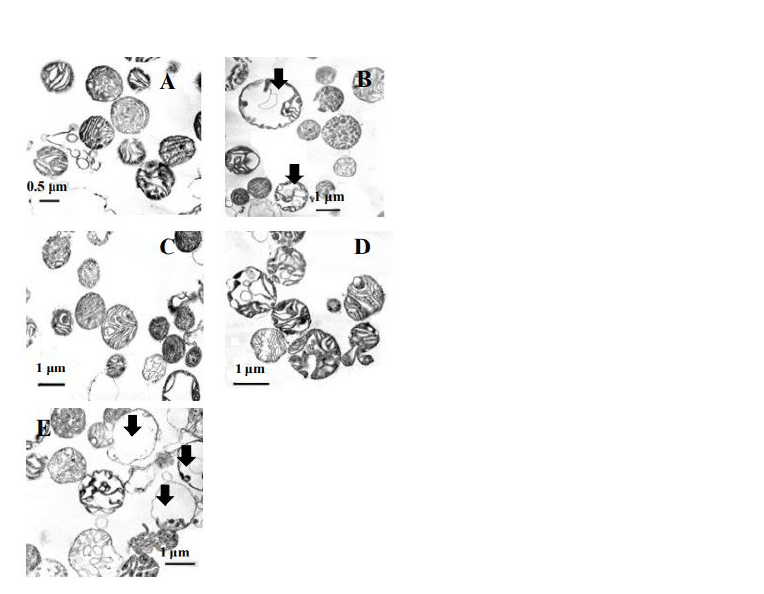
Figure 7. Micro-images of transmission electron microscopy of the E. magnusii mitochondria. ( A ) —control, ( B )—after a 3-min incubation with the antioxidant enzyme inhibitors of 4 mM ATZ and 4 mM DDC; ( C )—after a 1-min incubation with 5 mM Mg 2+ and 5 mM Pi followed by a 3-min treatment with the antioxidant enzyme inhibitors of 4 mM ATZ and 4 mM DDC; ( D )—after a 1-min incubation with10 mM NADH followed by a 3-min treatment with the antioxidant enzyme inhibitors of 4 mM ATZ and 4 mM DDC; ( E )—after a 1-minute incubation with 5 mM GSH followed by a 3-min treatment with the antioxidant enzyme inhibitors of 4 mM ATZ and 4 mM DDC.